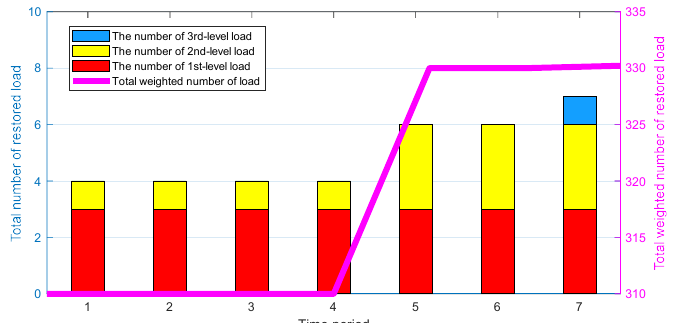
Figure 8. Critical load restoration of Strategy 2.